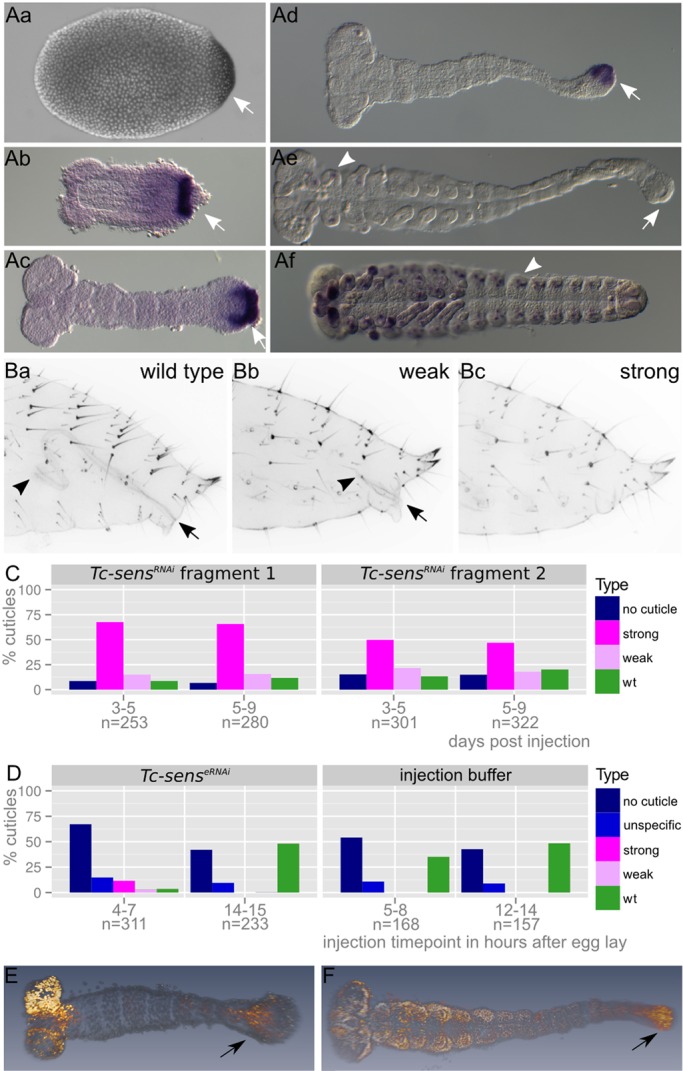
Tc-sens is required in germ rudiments for hindgut development. (A) Expression of Tc-sens starts at the posterior pole in undifferentiated blastoderm embryos and is maintained in the GZ throughout elongation (arrows in Aa-d). During germ band retraction the posterior expression vanishes (arrow in Ae) and arises de novo in putative PNS precursors (arrowheads in Ae,f). (B) Tc-sensRNAi cuticle phenotype. Arrow and arrowhead mark extremes of hindgut. Weak phenotypes (Bb) show a shortened hindgut compared with wild type (Ba), while strong phenotypes lack the hindgut altogether (Bc). (C) Quantitation of phenotype classes in experiments with two non-overlapping dsRNA fragments. (D) Embryonic RNAi reproduced the parental RNAi phenotype when injected at 4-7 h AEL. Later injection (14-15 h AEL) did not elicit the hindgut phenotype, indicating an early essential function of Tc-sens in the GZ. The large proportion of ‘no cuticle’ and ‘unspecific’ phenotypes is due to artifacts of embryonic injection. (E,F) EdU cell proliferation assay in elongating (E) and elongated (F) germ bands. Proliferating cells are in orange (Alexa 488), nuclei are in gray (Hoechst 33342). The arrows indicate EdU marked cells in the GZ.